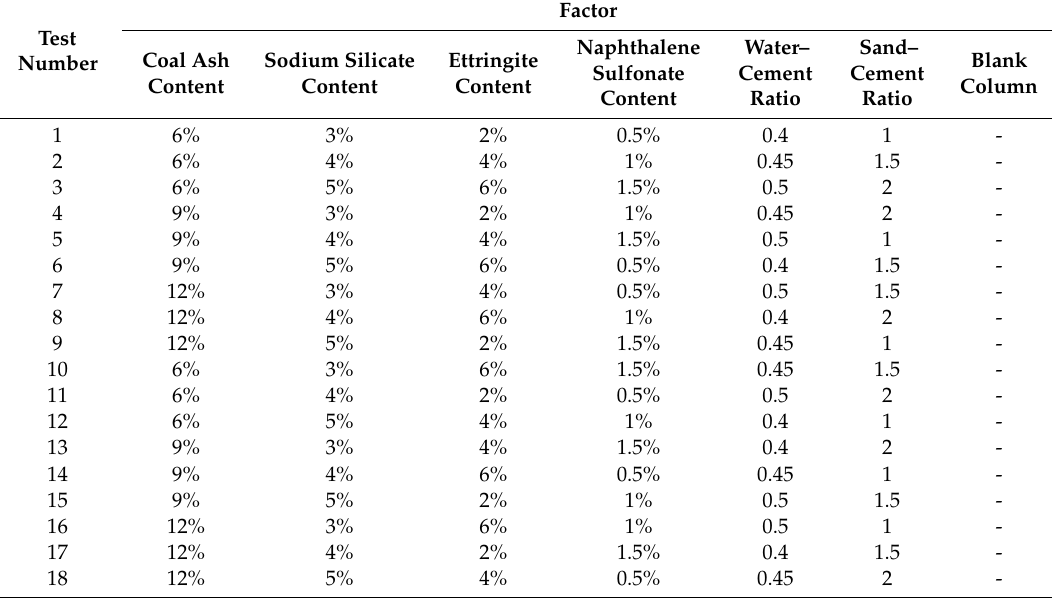
Table 4. Anchoring agent material ratio